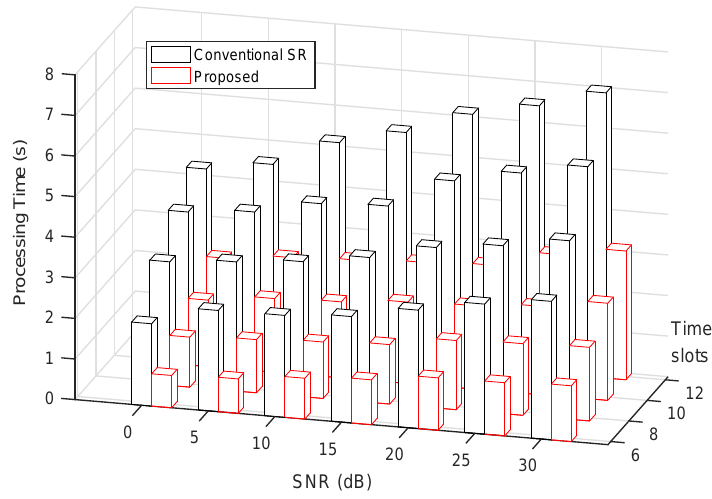
Figure 4. Comparison of the proposed and SR algorithms in terms of processing